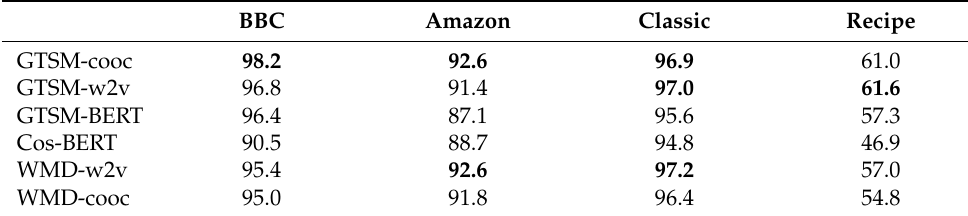
Table 1. F1 score for k -NN compared to baseline methods.